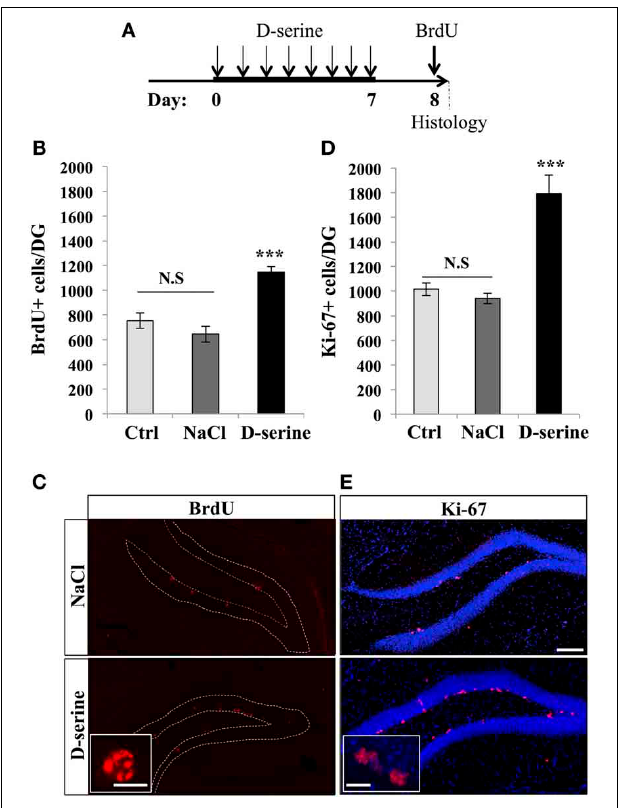
FIGURE 1 | D-serine increased cell proliferation in the dentate gyrus. (A) Experimental timeline: Mice were injected intraperitoneally every day with 50mg/kg of D-serine, for 8 consecutive days. One day after the last injection, mice were pulsed with BrdU (100mg/kg, 3 injections every 2h) and, 2h later, euthanized and prepared for immunohistochemistry. (B) Histogram showing the number of BrdU-expressing cells per dentate gyrus of animals injected with D-serine, NaCl or not injected (Ctrl). Animals: n = 4 per group. (C) Confocal maximal projection micrographs of hippocampal sections immunostained for BrdU in the two injected groups (D-serine and NaCl). Inset: Higher magnification micrograph of a BrdU-expressing cell. (D) Histogram showing the number of Ki-67–expressing cells. Animals: n = 4 per group. (E) Confocal maximal projection micrographs of hippocampal sections immunostained for Ki-67 in the two experimental groups (D-serine and NaCl). Inset: Higher magnification micrograph of Ki-67-expressing cells. Blue: Dapi staining. Each value represents the mean ± SEM; post-hoc bilateral Student’s t -test, ( ∗∗∗ p < 0 . 001), N.S., non-significant ( p > 0 . 05). Scale bar: 100 μ m, insets 10 μ m.